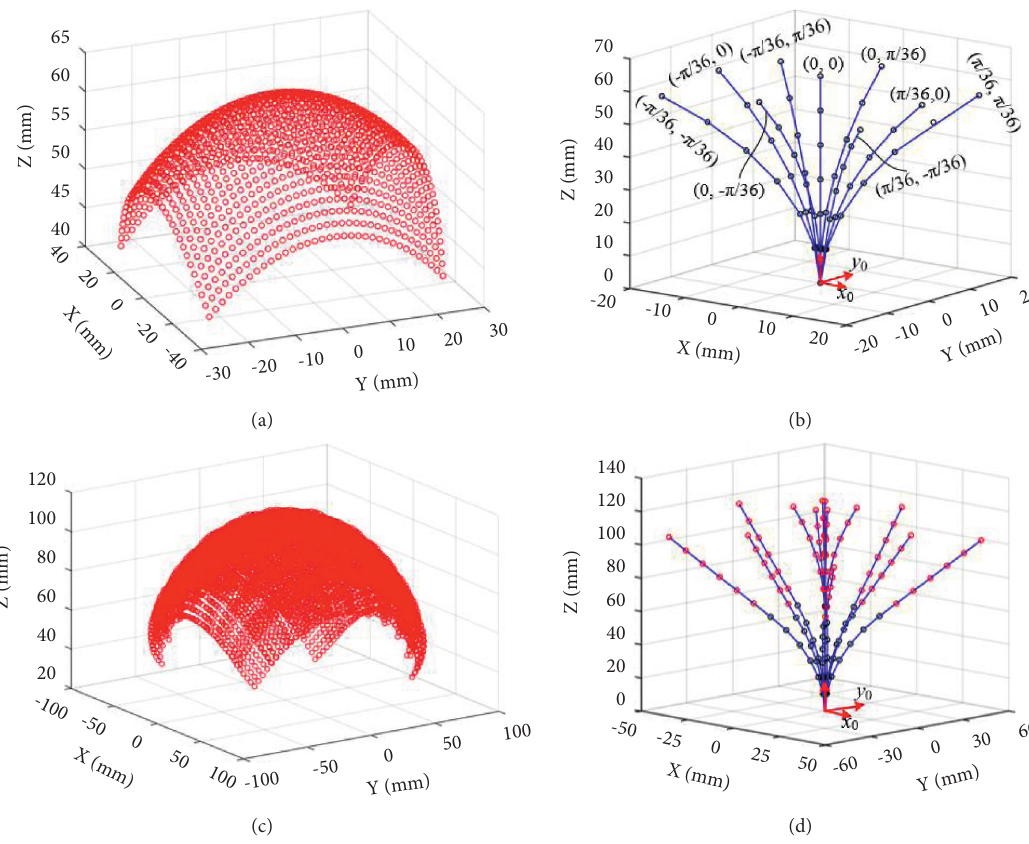
Figure 9: The workspace and bending configurations of the robot. (a) The workspace of the proximal section. (b) Nine bending con- figurations of the proximal section. (c) The robotic workspace. (d) Multiple bending configurations of the robot.